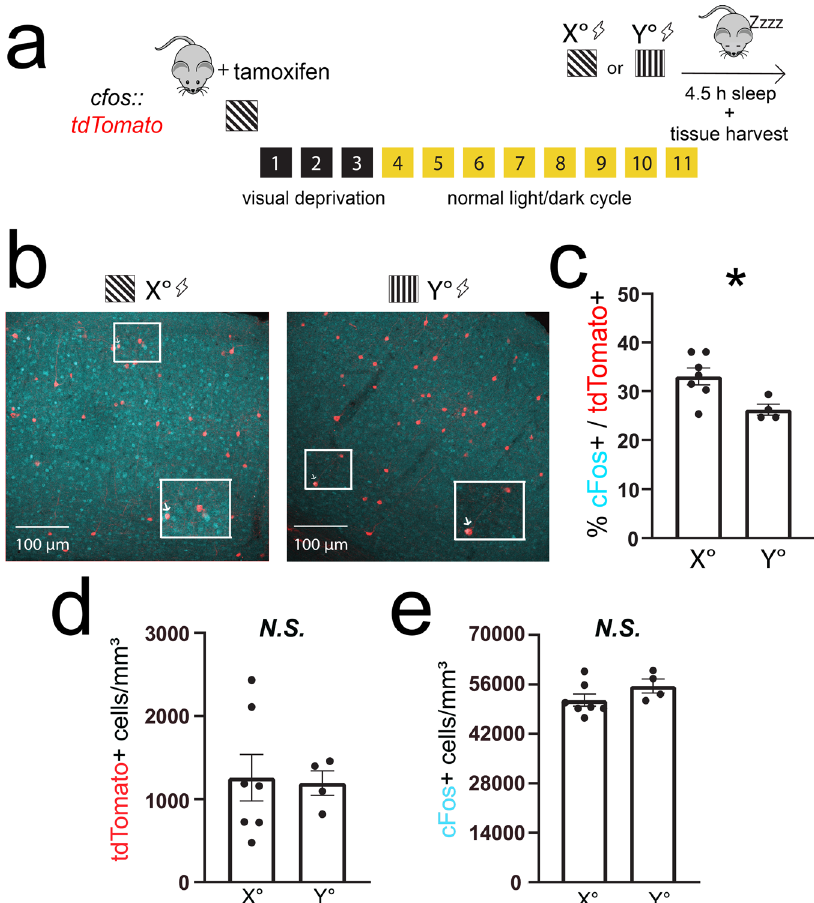
Fig. 4 TRAPed V1 neurons selective for the conditioned stimulus are reactivated in post-conditioning sleep. a cfos::tdTom mice had recombination induced to a speci fi c angle ( X °). Eleven days later, they were cue conditioned to either the same angle as induction ( X °; n = 7 mice) or an alternate angle ( Y °; n = 4 mice). All mice were allowed 4.5 h of post-conditioning ad lib sleep prior to tissue harvest. b , c Representative images showing overlap of cFos expression (cyan) with tdTomato (red). The boxed region is magni fi ed as an inset with an arrow indicating an overlapping neuron. Expression of cFos in tdTomato-labeled cells was greater for mice conditioned to the same orientation used for TRAP labeling (* p = 0.0106 [ t = 2.633, DF = 63], nested t test). d , e Densities of tdTomato + and cFos + neurons were similar in X ° and Y °-conditioned mice. Values indicate mean ±